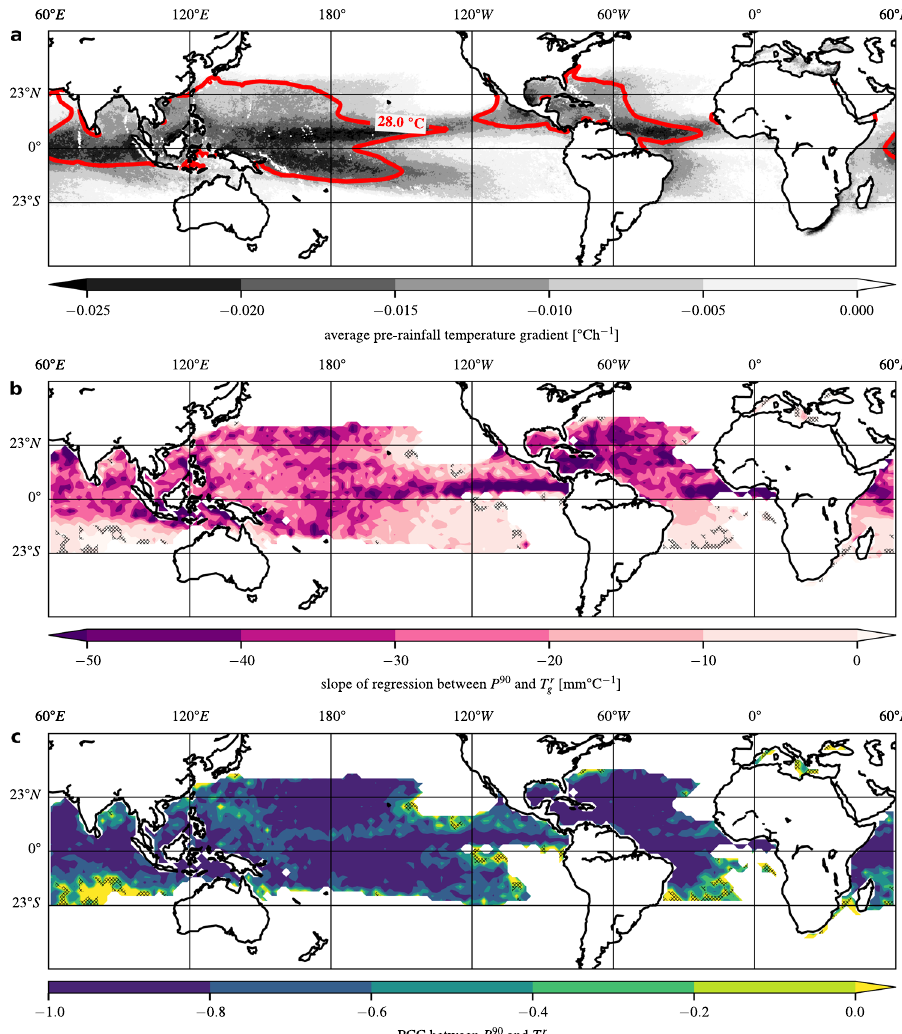
Fig. 3 Average temporal temperature gradients, scaling factors between temperature gradients and rainfall intensities and their corresponding linear in [°Ch − 1 ]) for all episodes in July – August – September – October (JASO). b correlation values. a Average pre-rainfall temperature gradient per pixel ( T r g ) and extreme-rainfall intensities ( P 90 ) in JASO. The slope of the linear regression between intensities Scaling between temporal temperature gradients ( T r g ( P 90 in [mmh − 1 ]) and gradients ( T r in [°Ch − 1 ]) is indicated by color. The regression is applied considering only those bins for which the representative g temperature gradient is negative (see also Fig. 2e, f). Pixels with less than 20 (of a total of 40) such bins, or less than 100 data points per bin, are depicted as white. Pixels over landmasses are also depicted as white. Pixels with a p -value larger than 5% are shaded with crossed black lines. c Corresponding Pearson Correlation Coef fi cients (PCCs) of the linear regressions in b